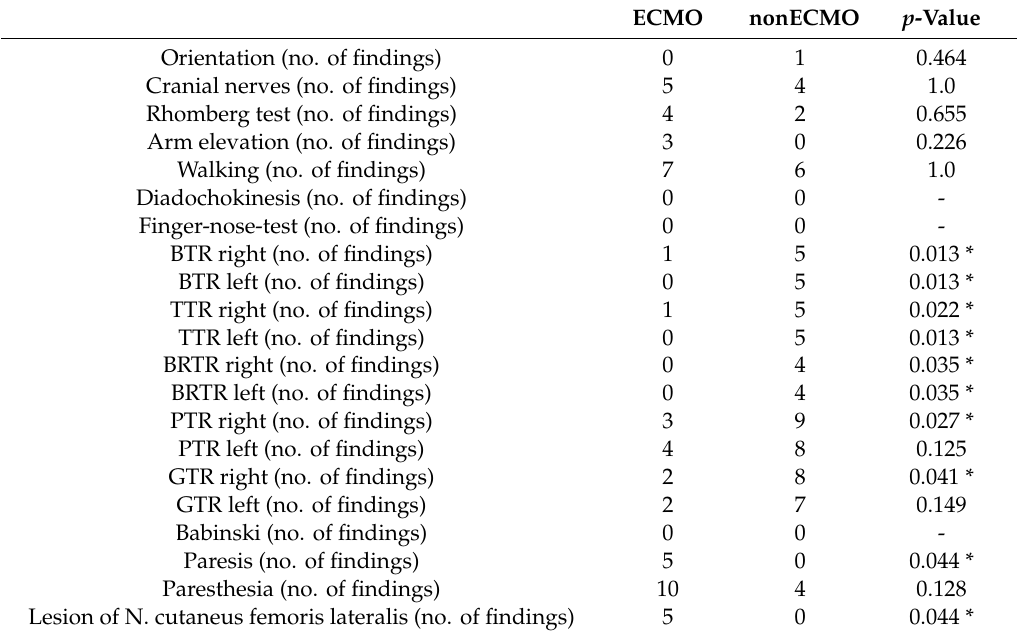
Table 2. Summarized findings of neurologic examination by treatment group. Any abnormal finding was counted, findings of patients were